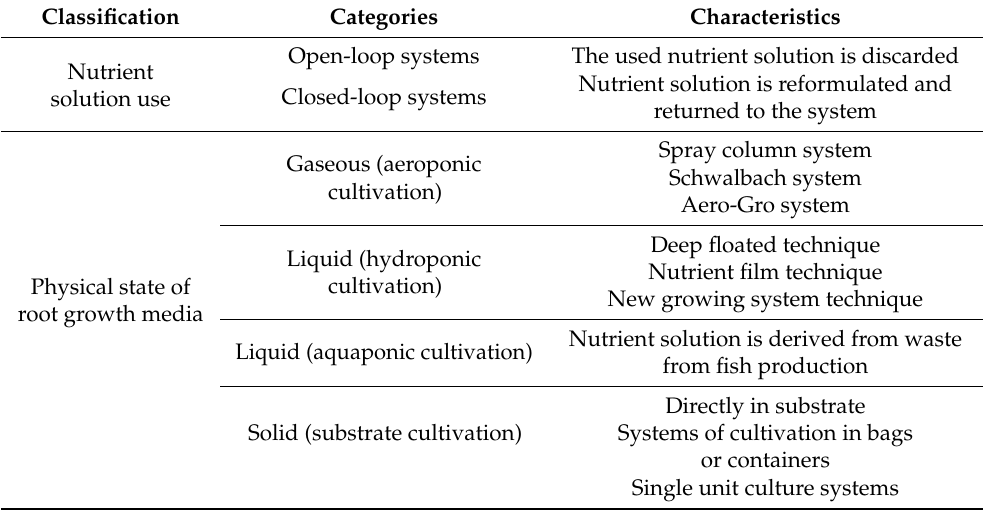
Table 1. Classification of soilless cropping